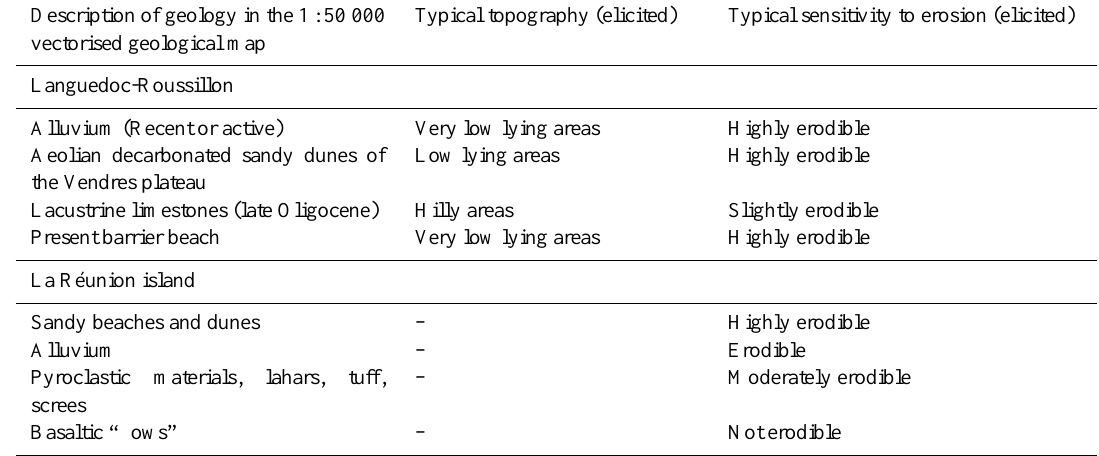
Table 4. A selection of geological classes and their associated erodibility and topography as derived for preparing the zonation. In Languedoc- Roussillon, 170different geological classes have been classified according to their susceptibility to erosion and typical topography (18 in La R´eunion